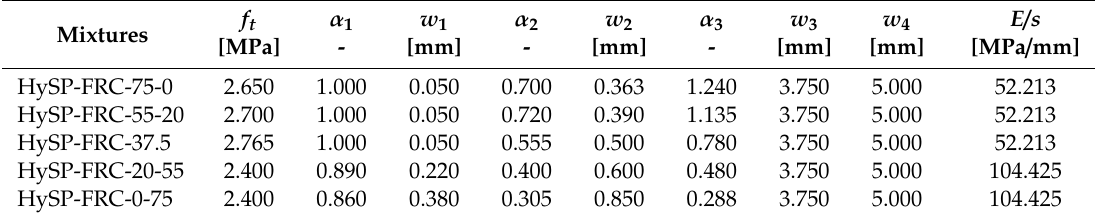
Table 2. Parameters of the Stress–Crack Opening Relations Obtained Through the Inverse Analysis.